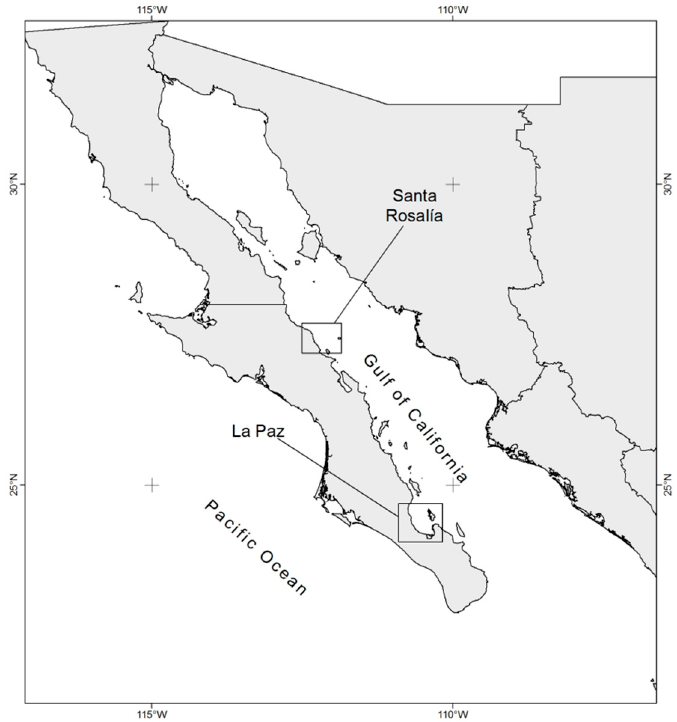
Figure 1. Sampling sites of Kyphosus vaigiensis , Stegastes rectifraenum , and Balistes polylepis in the vicinity of Santa Rosalía (STR) and Bahía de La Paz (LAP).